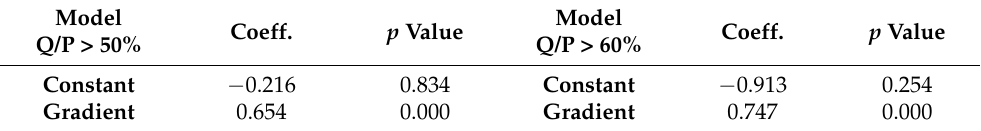
Table 4. Inferential statistics of Equations (8) and (9) at α = 0.05.